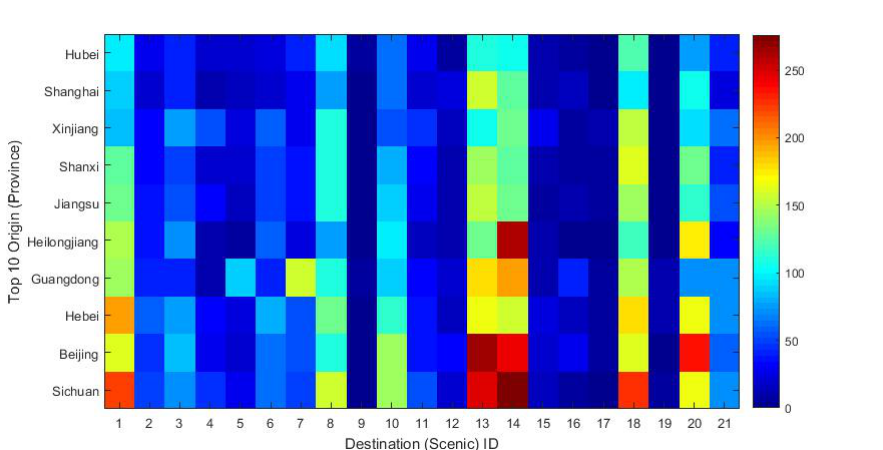
Figure 9. OD matrix of group tourists. X -axis is the scenic ID of scenic areas and Y -axis is top 10 provinces with the most group tourists. (Top 1 is Sichuan, Top 10 is Hubei).